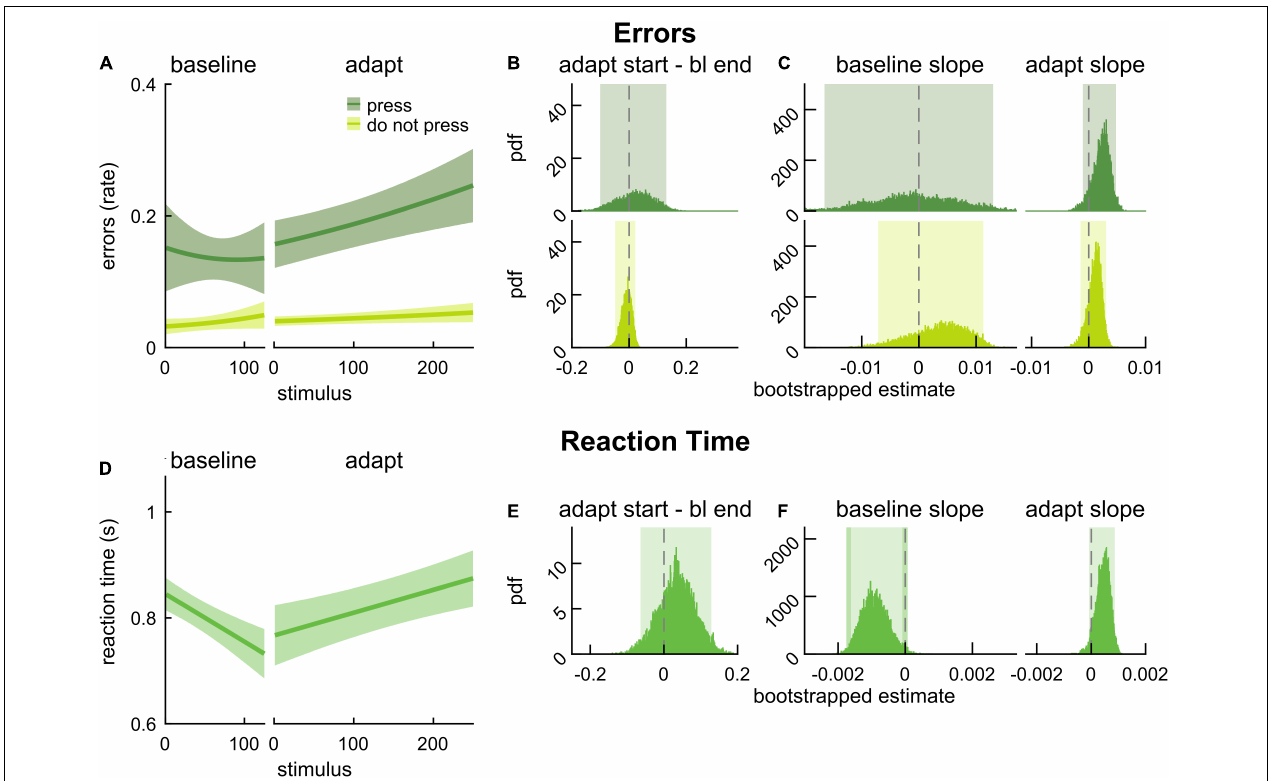
FIGURE 2 | 2-back performance during baseline walking and locomotor adaptation in young adults. (A) Logistic fits (mean and shaded SE) of the error rate in response to press stimuli (dark green) and do not press stimuli (light green) during an auditory 2-back task. (B) PDF of the differences in error rate estimates between the start of adaptation (first value) and the end of baseline (last value) from logistic model fits. (C) PDF of slope estimates for logistic fits of error rate in baseline and adaptation. (D) Linear fits (mean and shaded SE) of reaction time. (E) PDF of the differences in reaction time estimates between the start of adaptation (first value) and end of baseline (last value) estimated from linear model fits. (F) PDF of slope estimates for linear fits of reaction time in baseline and adaptation. Lighter shaded areas of PDF plots indicate the 95% CI; when applicable, darker shaded areas of PDF plots indicate the correction to the CI for 3 comparisons. SEs, PDFs, and CIs were obtained through bootstrapping. Cognitive performance was unchanged in